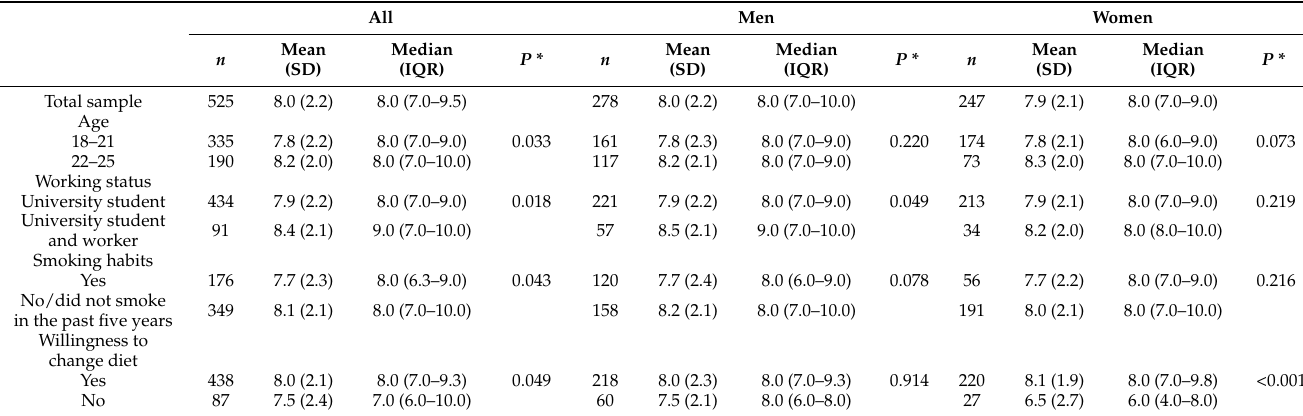
Table 1. Adherence to MedDiet and related variables.